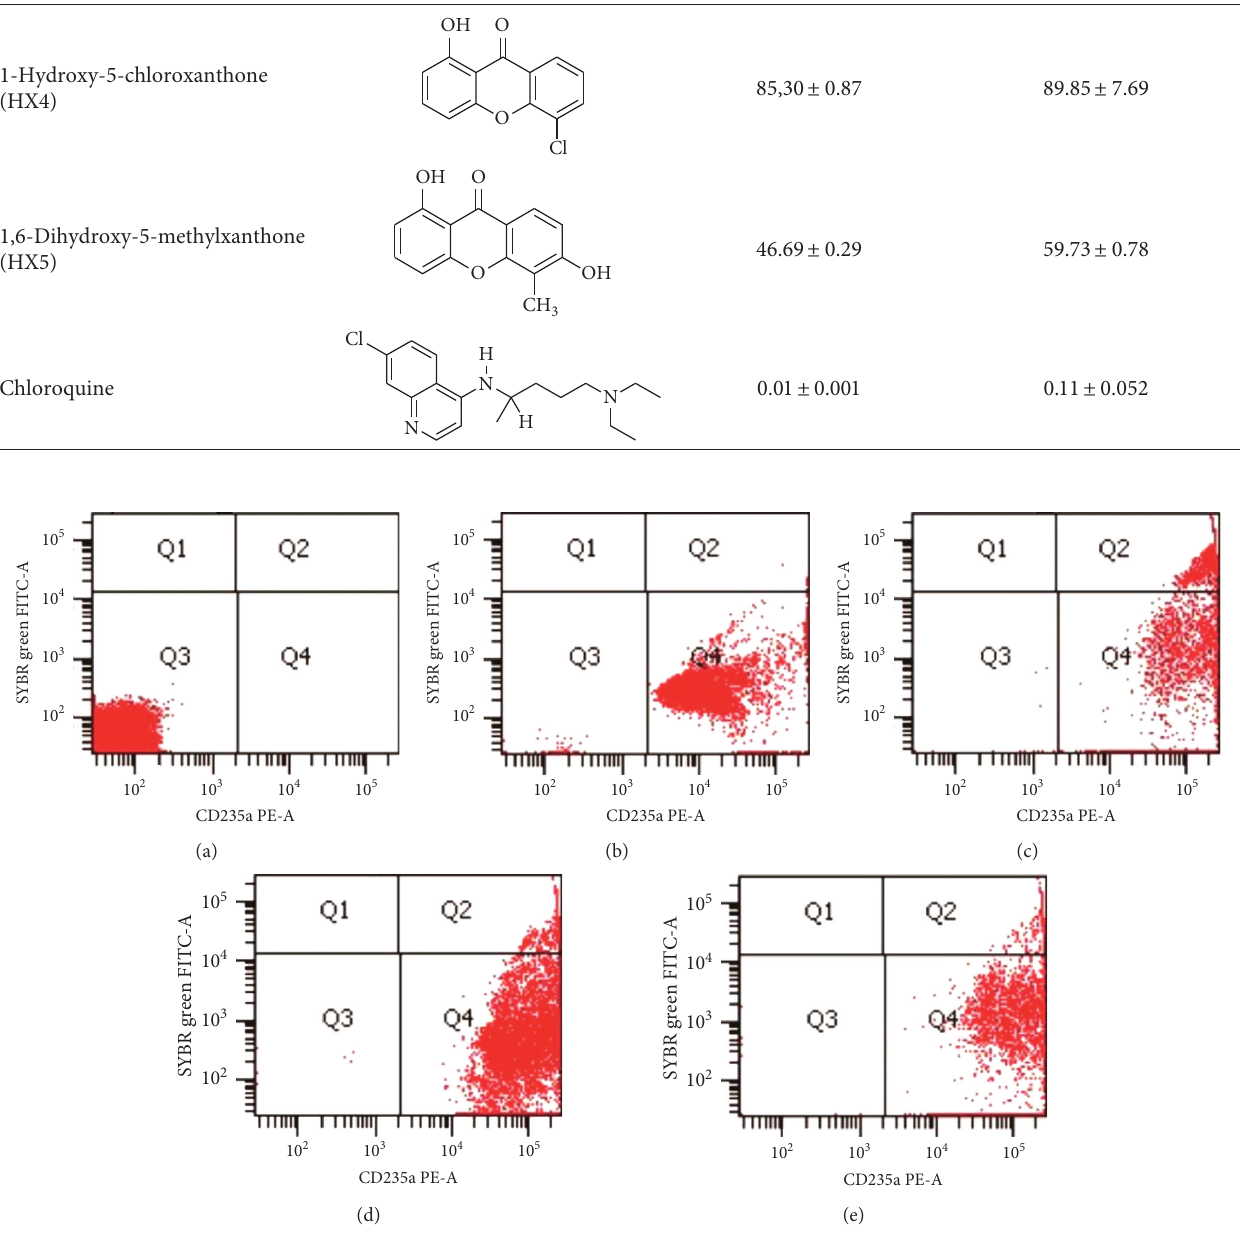
Figure 1: The flow cytometric analysis diagram of compound HX1 on Plasmodium falciparum 3D-7 with 72 hours incubation. (a) Normal unstained erythrocytes. (b) Normal stained red erythrocytes (uninfected). (c) P. falciparum -infected erythrocytes control. (d) P. falciparum - infected erythrocytes with HX1 (concentration of 102.38 μ M). (e) P. falciparum -infected erythrocytes with HX1 (concentration of 204.75 μ M). The diagram was divided into four regions: Q1 (FITC/PE. ± ); Q2 (FITC/PE. +/+); Q3 (FITC/PE. -/-); Q4 (FITC/PE. ±